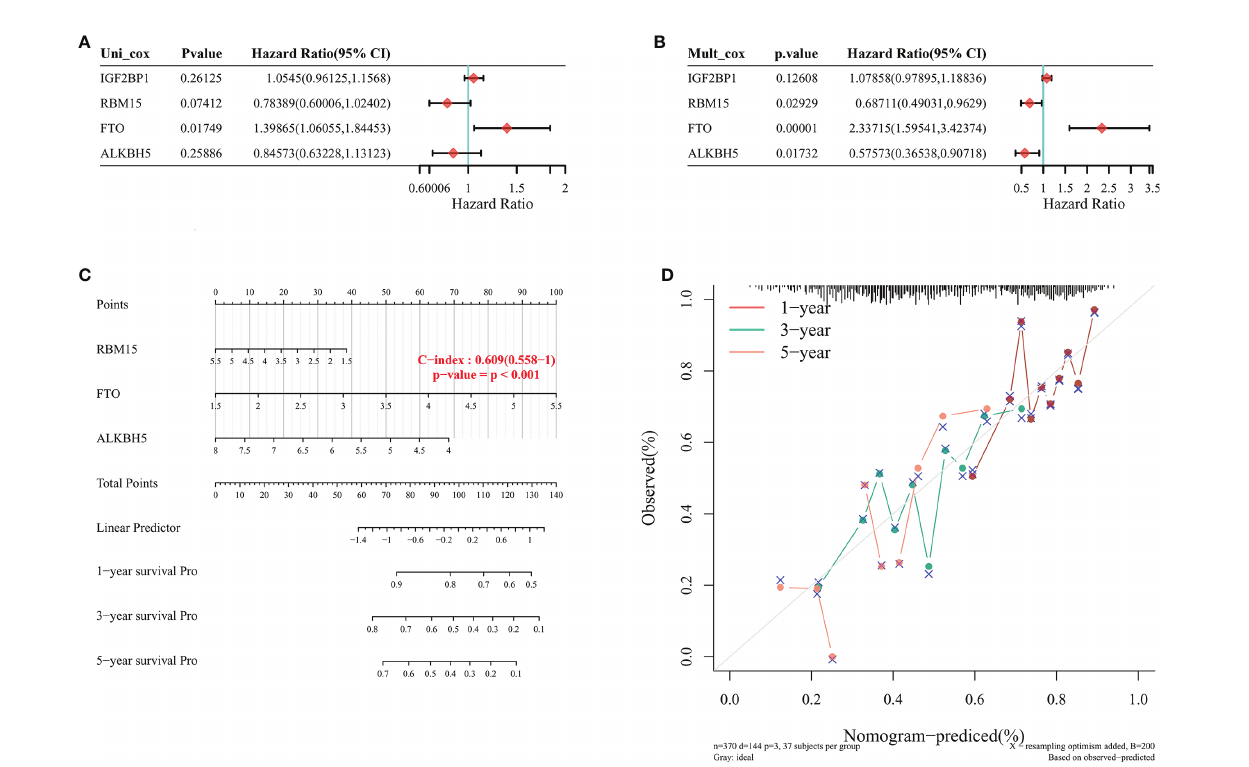
FIGURE 5 | Nomogram plot construction in TCGA database. (A, B) Univariate and multifactorial cox analysis of p-value, risk factor HR, and con fi dence interval for 4-m6A RNA methylation regulator expression and clinical characteristics. (C) Columnar plots to predict 1-year, 3-year, and 5-year overall survival of STAD patients (D) Calibration curves of the overall survival line plot model in the discovery group. The diagonal dashed line indicates the ideal column line plot, the blue, red, and orange lines indicate the observed 1-year, 3-year, and 5-year column line plots.